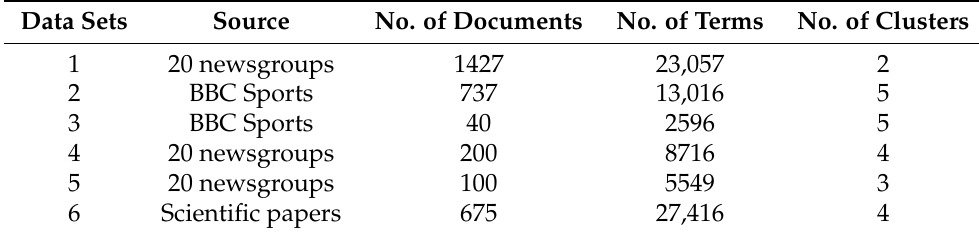
Table 2. Benchmark data sets Data